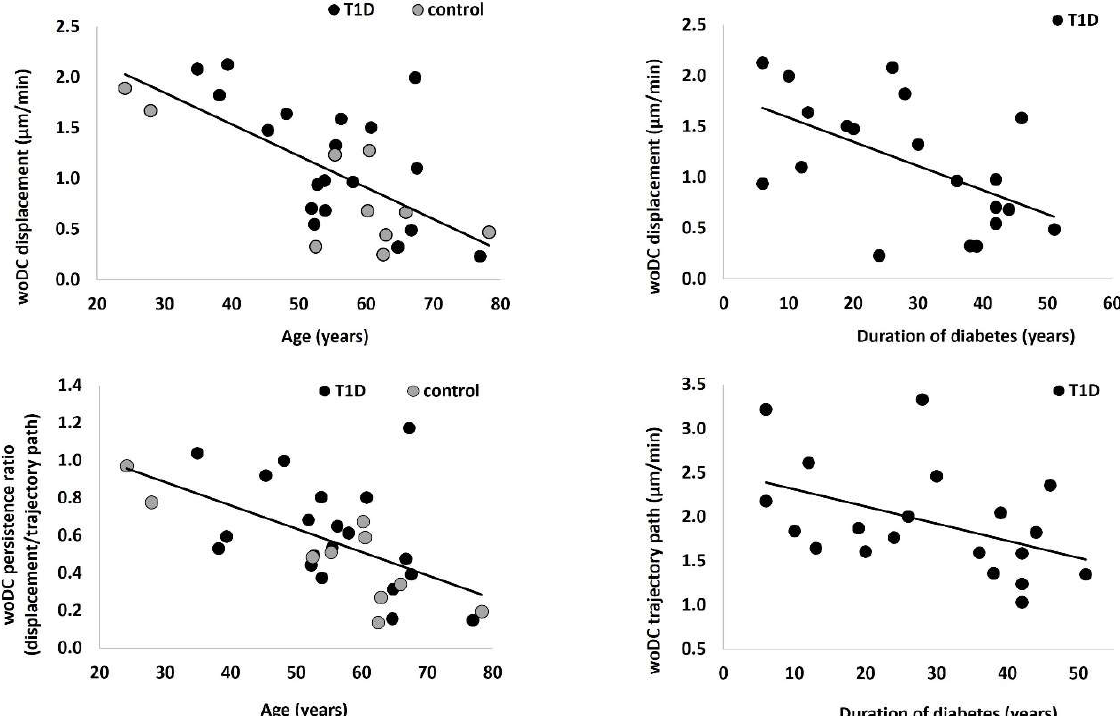
Figure 2. Relationship between dendritic cell dynamics and participant characteristics. woDCs; cells without visible dendrites, T1D; Type 1 diabetes.